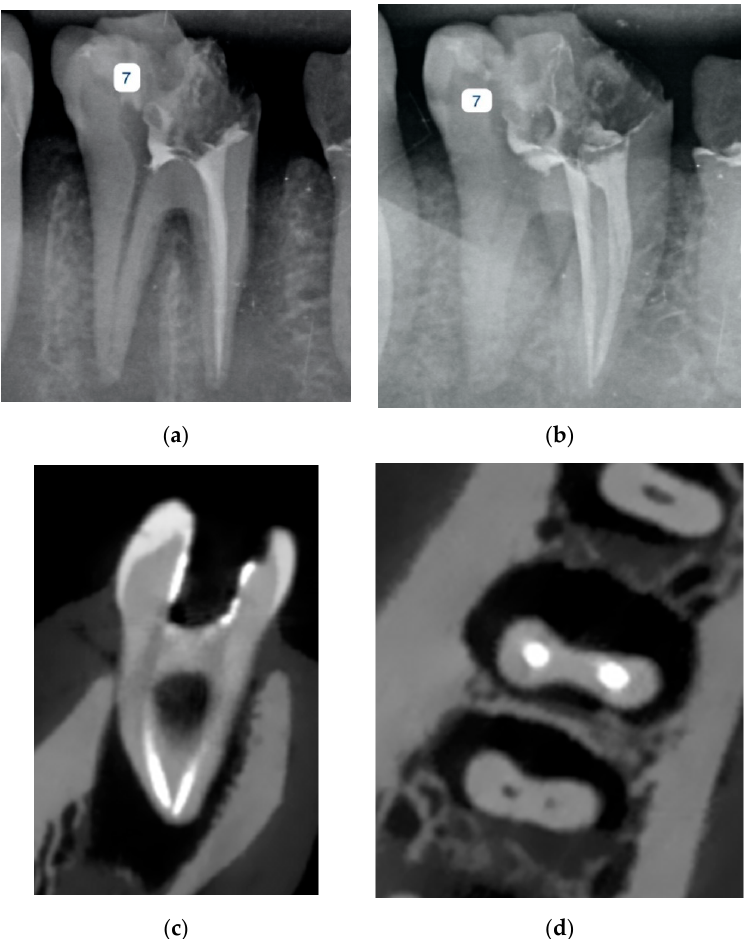
Figure 1. Digital periapical radiographs with ( a ) perpendicular and ( b ) distal horizontal angles and cone beam computed tomography (CBCT) images in ( c ) coronal and ( d ) axial views of a tooth with a separated file in the mesiolingual root canal.